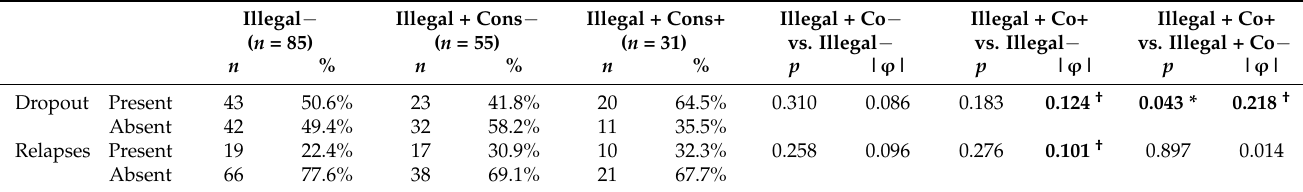
Table 4. Comparison between the groups for CBT outcomes.